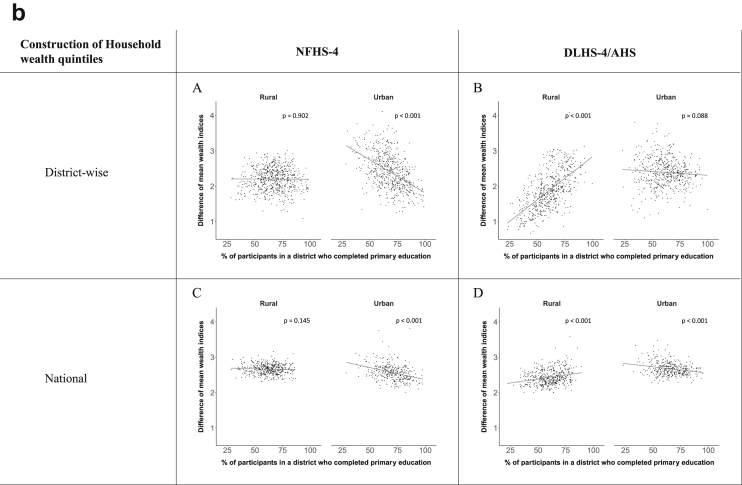
Association of a district's primary school completion rate with the difference in the continuous household wealth index between highest and lowest household wealth quintile (computed for each district) stratified by urban-rural residency. The asset score was standardized by subtracting the mean and dividing by one standard deviation. This analysis was performed separately for urban and rural areas. The grey line through the scatterplots has been fitted using ordinary least squares regression (with each data point in the plot having the same weight). The p-value shows whether the slope of the grey line is significantly different from zero. We excluded districts with fewer than 20 participants in the highest or lowest household wealth quintile.